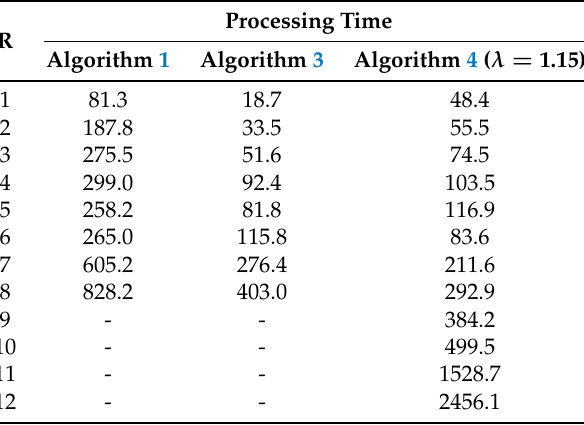
Table 6. The processing time when defender’s resources